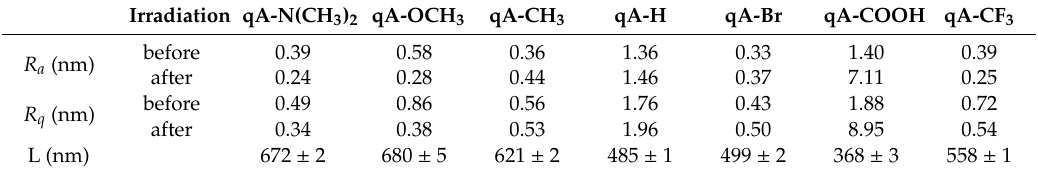
Figure 1. Surface topography of selected quinoline azo-polymers thin films obtained from atomic force microscopy (AFM). Table 1. Sample thickness (L) and values of roughness parameters ( Ra , Rq ) before and after